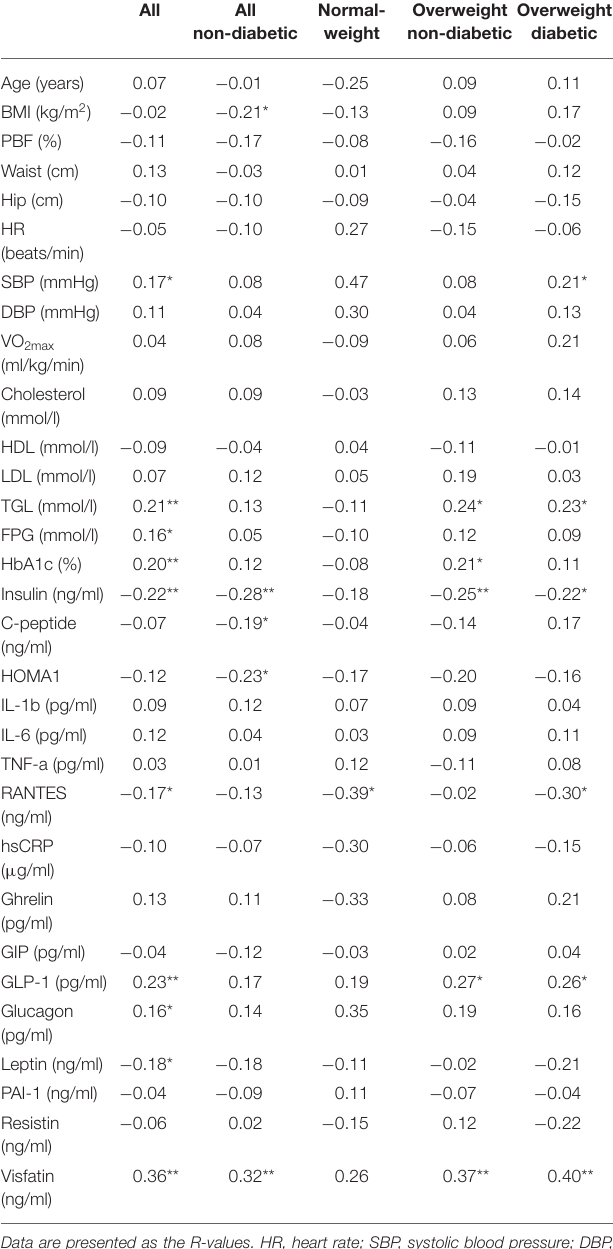
TABLE 3 | Multivariate Linear Regression analysis with UCN3 as TABLE 2 | Spearman Correlation ranking of UCN3 with subject characteristics dependent variable. at baseline. All All Normal- Overweight Overweight Independent All non-diabetic weight non-diabetic diabetic variables